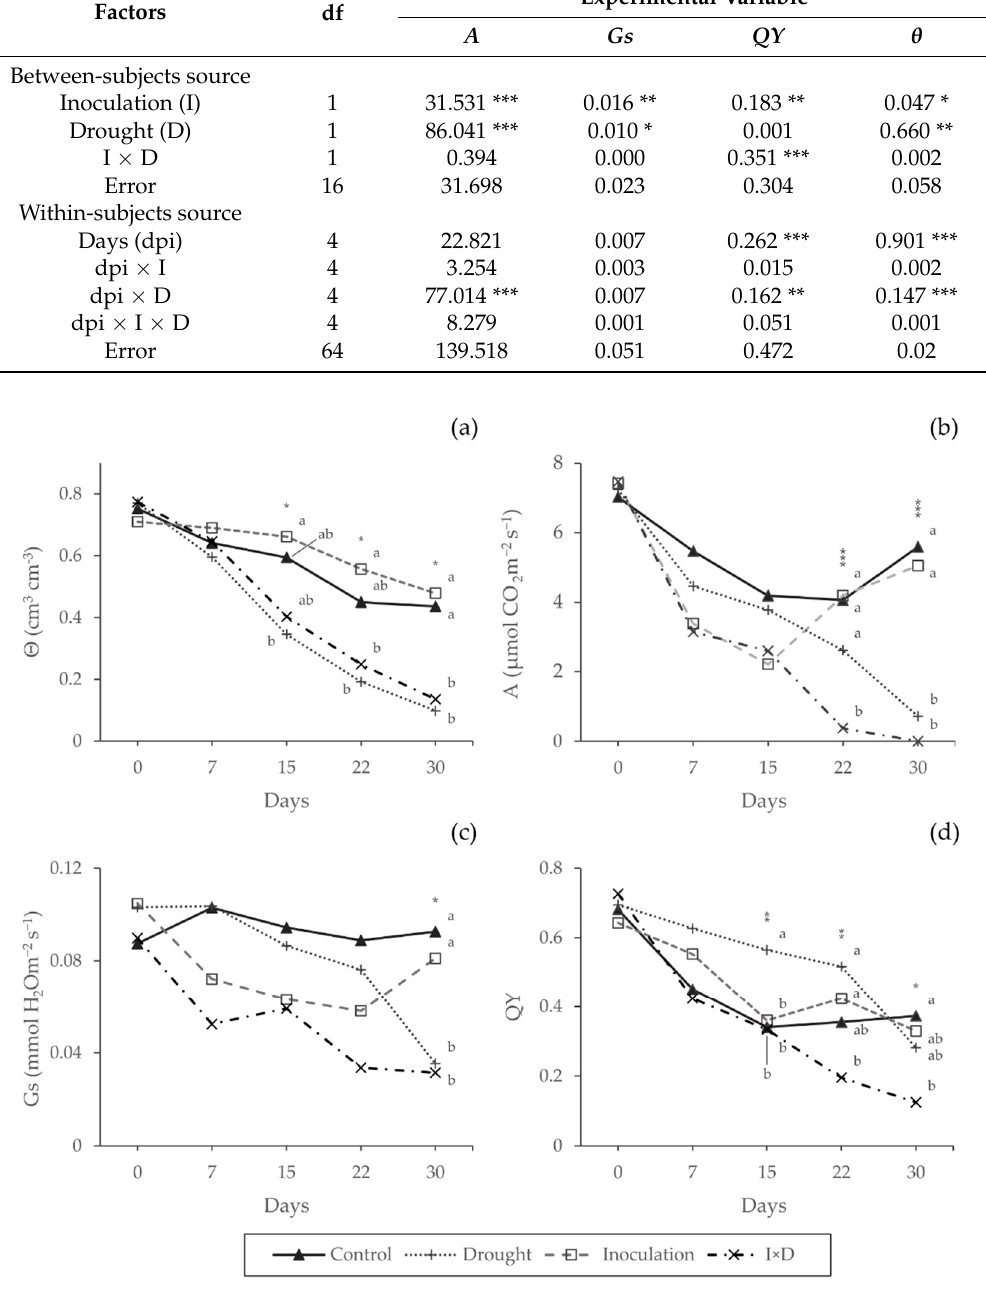
Figure 2. Physiological characterization of Quercus ilex L. seedlings during the experiment. ( a ) Volumetric water content ( θ ). ( b ) Net photosynthesis ( A ). ( c ) Stomatal conductance ( Gs ). ( d ) Photosynthetic efficiency of Photosystem II ( QY ). Points with the same letter are not significantly different for the analyzed dpi ( p > 0.05). In sets of points where there were no significant differences for dpi according to the ANOVA test, the letters are not presented. Differences between values of the same days are represented only when significant at p < 0.05 (*), p < 0.01 (**) and p < 0.001 (***).